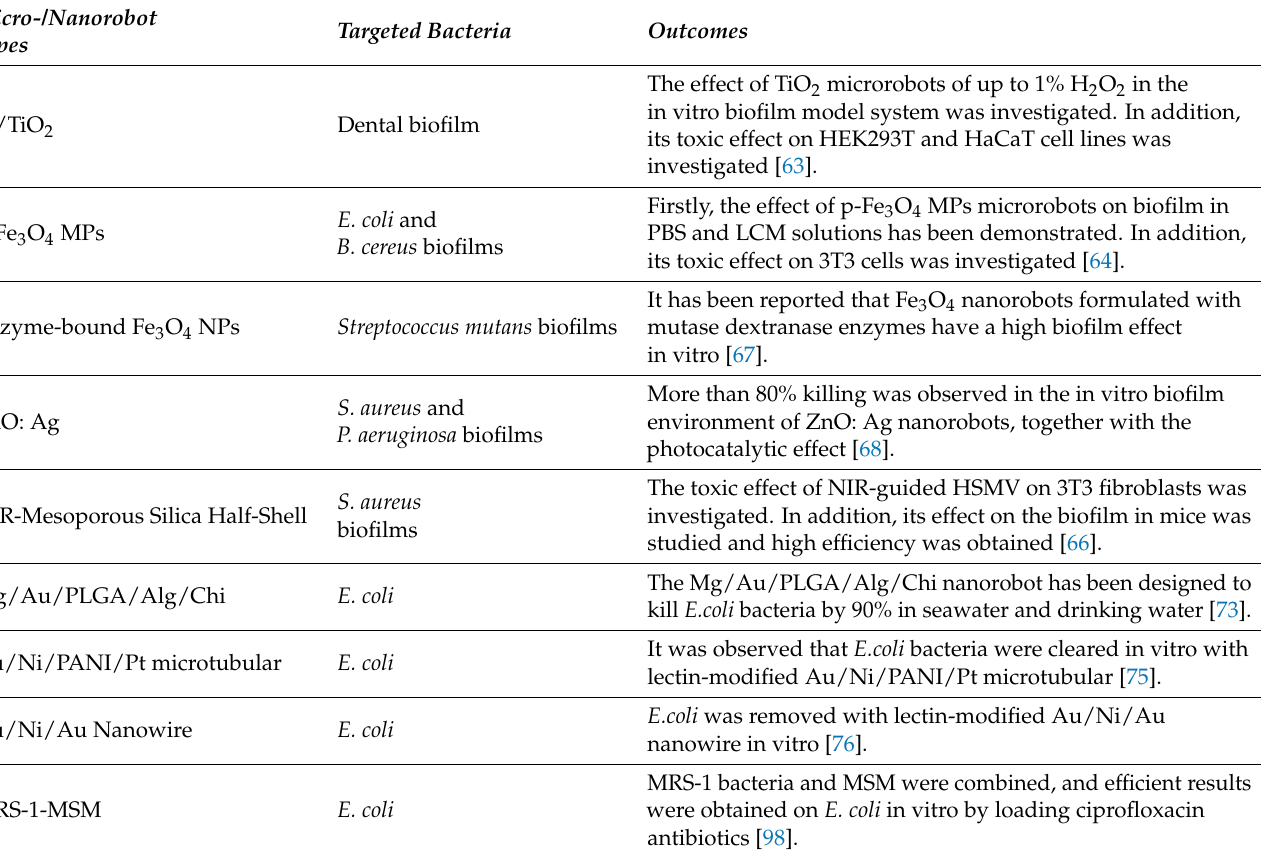
Table 1. Studies of micro-/nanorobots against different